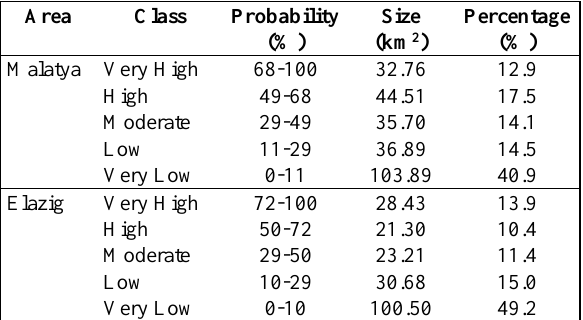
Table 1. The landslide probability distributions obtained from the RF